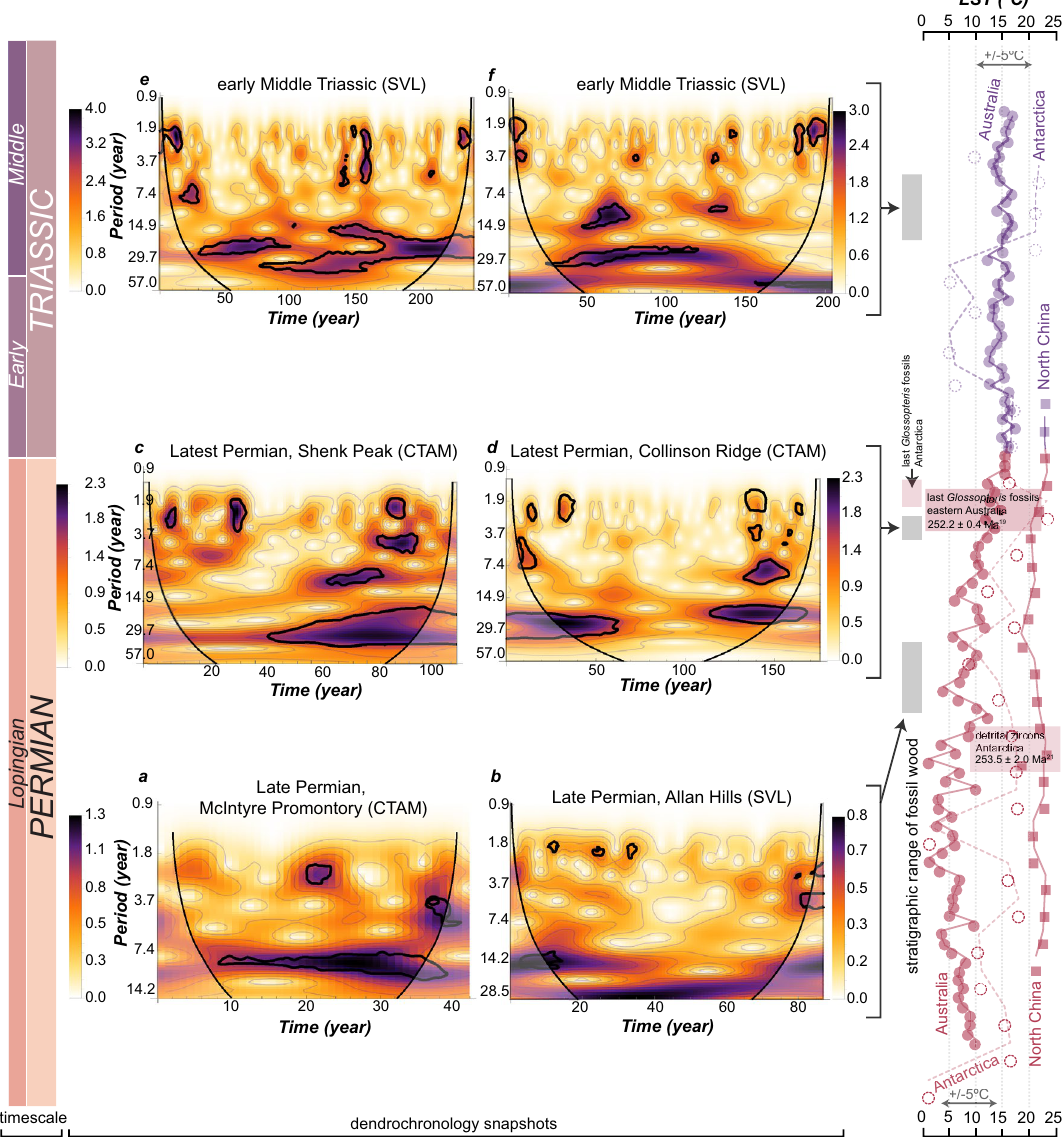
Figure 4. Wavelet scalograms of the RWI data and land surface temperature (LST). ( a – f ) The color spectrum indicates wavelet power (square of wavelet coefficient), higher power indicating a stronger signal in the data. The shaded envelope is the cone of influence reflecting wavelet coefficients that are erroneous near the edge of each time series. The dark lines indicate the wavelet power domains that are significant as compared to red noise at the 0.05 level. The abscissa represents the time represented in each chronology and is directly related to the RWI data. The ordinate axis represents the Fourier period and is scaled with 16 voices per octave. ( g ) Land surface temperature (LST) through time in Antarctica (dashed line and dashed circles) 18 , eastern Australia 19 (solid line and filled circles), and North China 28 (solid line and filled squares). The symbols indicate average values binned evenly through each time interval, the lines are running averages of the data. Purple colors indicate Triassic data, and red colors indicate Permian data. LST estimates are based on the chemical index of alteration (CIA) 29 and are corrected for authigenic K concentrations 19,30 . Data for eastern Australia represent sedimentary CIA values, and are averaged between the Bowen and Sydney basins based on existing correlations and U–Pb ages 19 . Data for Antarctica is from Graphite Peak and represent paleosol CIA values 18 . Markers indicating the last occurrence Glossopteris fossils are shown for Antarctica 20 and eastern Australia 4,19 . The detrital zircon U–Pb for Antarctica is from Layman Peak in the Shackleton Glacier area 21 . Figure created using Adobe Illustrator, v. 25.0.1,